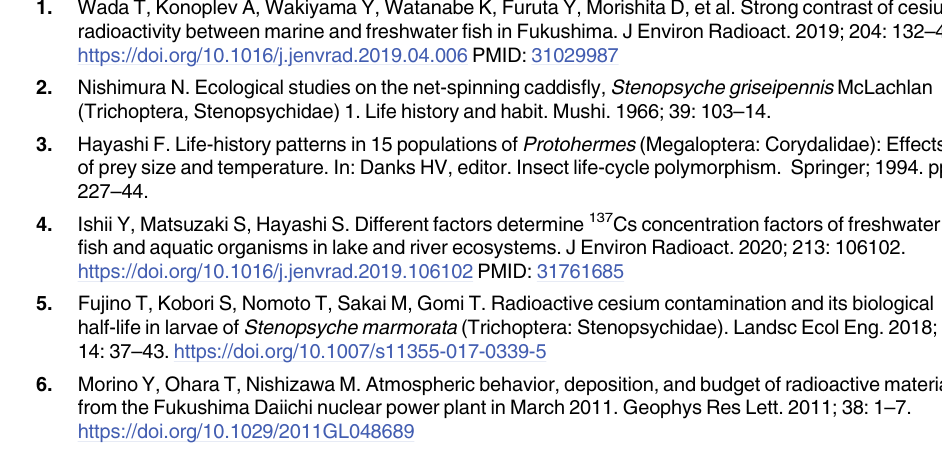
S1 Table. Results of the linear regression analysis of the inventory and the 137 Cs activity concentrations in aquatic insects, periphyton, and coarse particulate organic matter (CPOM). S2 Table. Results of the linear regression analysis of 137 Cs activity concentration and weight of individuals in aquatic